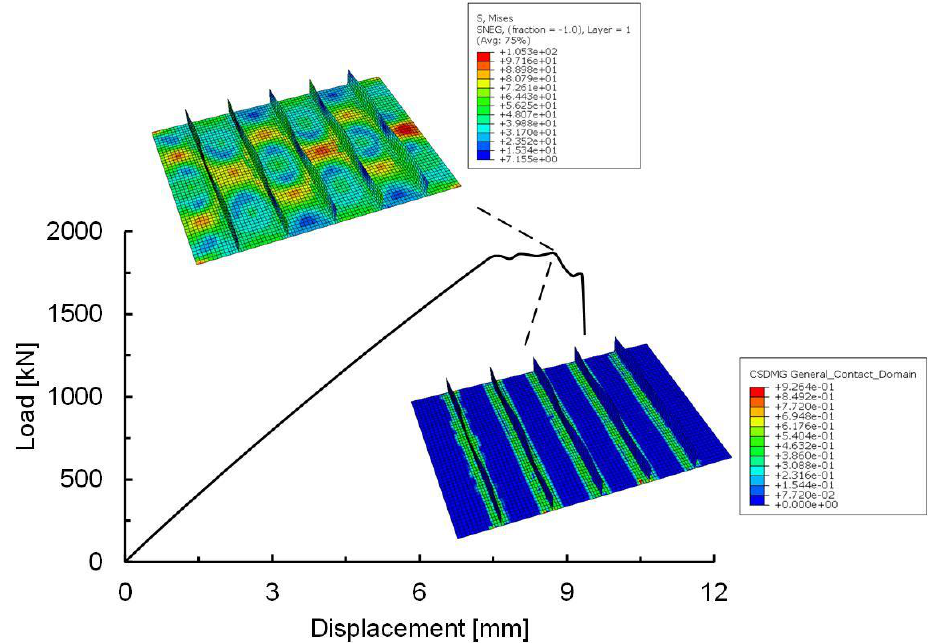
Figure 11. Load-displacement curve and von Mises stress plot at the ultimate load.